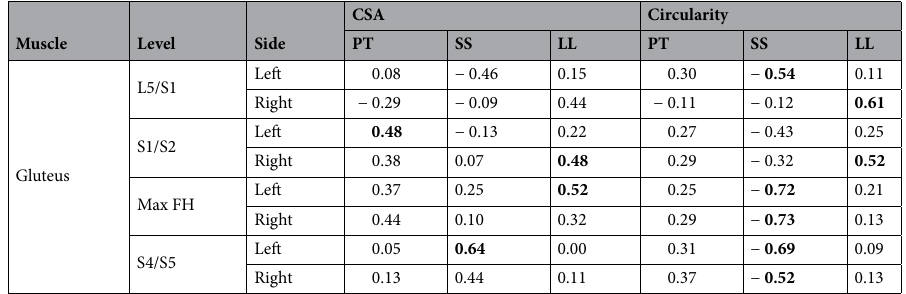
Table 7. Pearson’s correlation (r) of muscle morphometry (CSA and circularity) versus pelvic geometry (PT, SS, and L3–S1 LL). CSA was normalized by maximum femoral head cross-sectional area and pelvic geometry (PT, SS, and LL were normalized by supine values). Bold indicates significant results, P < 0.05.